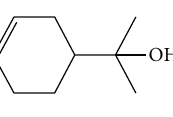
Figure 2: Molecular structure of